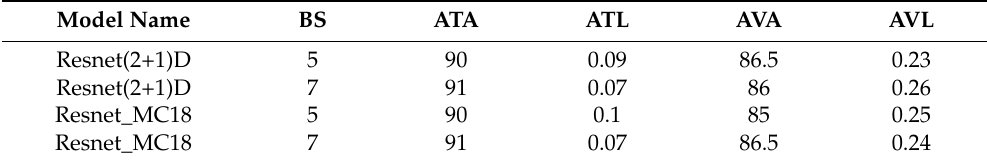
Table 9. Video classifier results by BS.